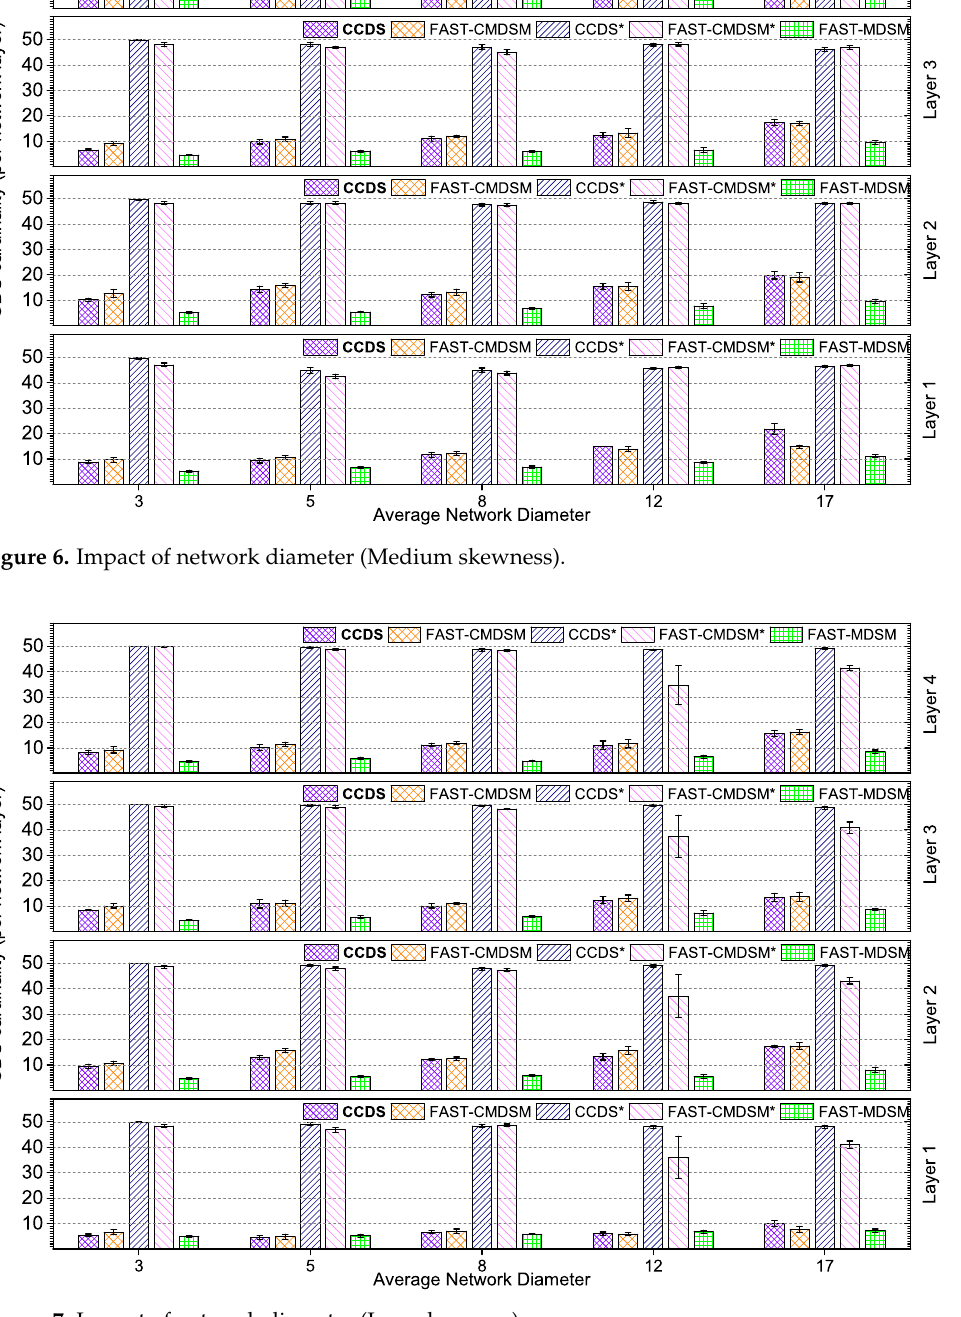
Figure 7. Impact of network diameter (Low